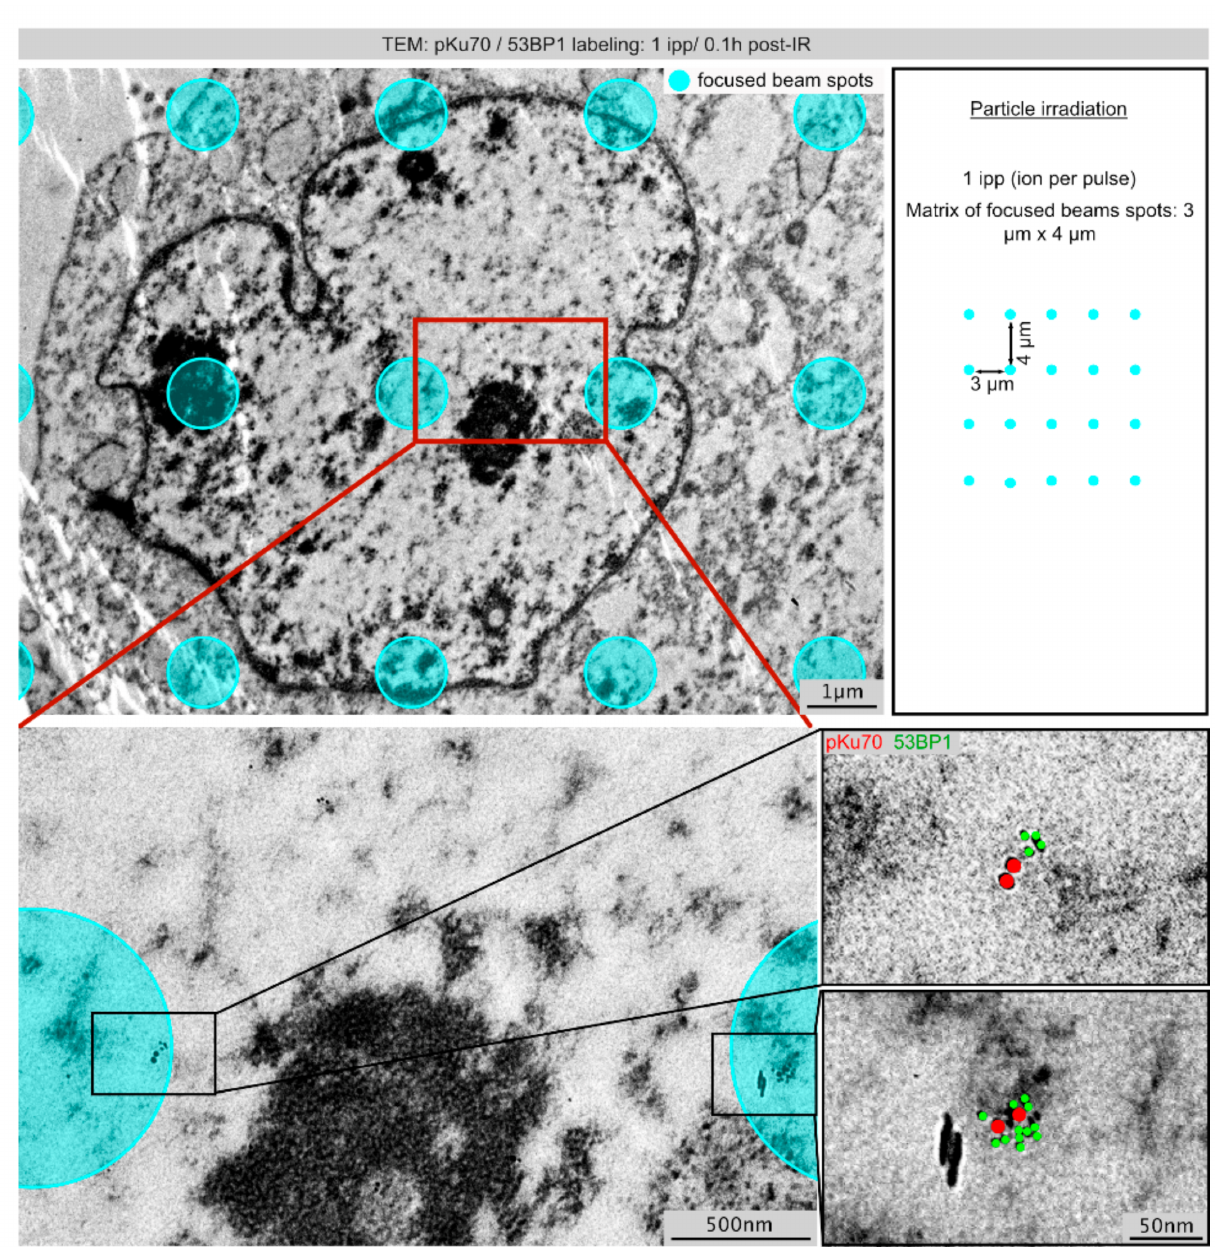
Figure 3. Spatial distribution of DNA lesions induced by single carbon ions (1 ipp) visualized by TEM. Micrograph of double-labeling for pKu70 (10 nm beads, colored in red) and 53BP1 (6 nm beads, colored in green) after focused microbeam IR with 1 ipp carbon ions. The pre-defined IR matrix with micrometer-sized beam spots is delineated as circular areas (cyan). Framed regions are shown at higher